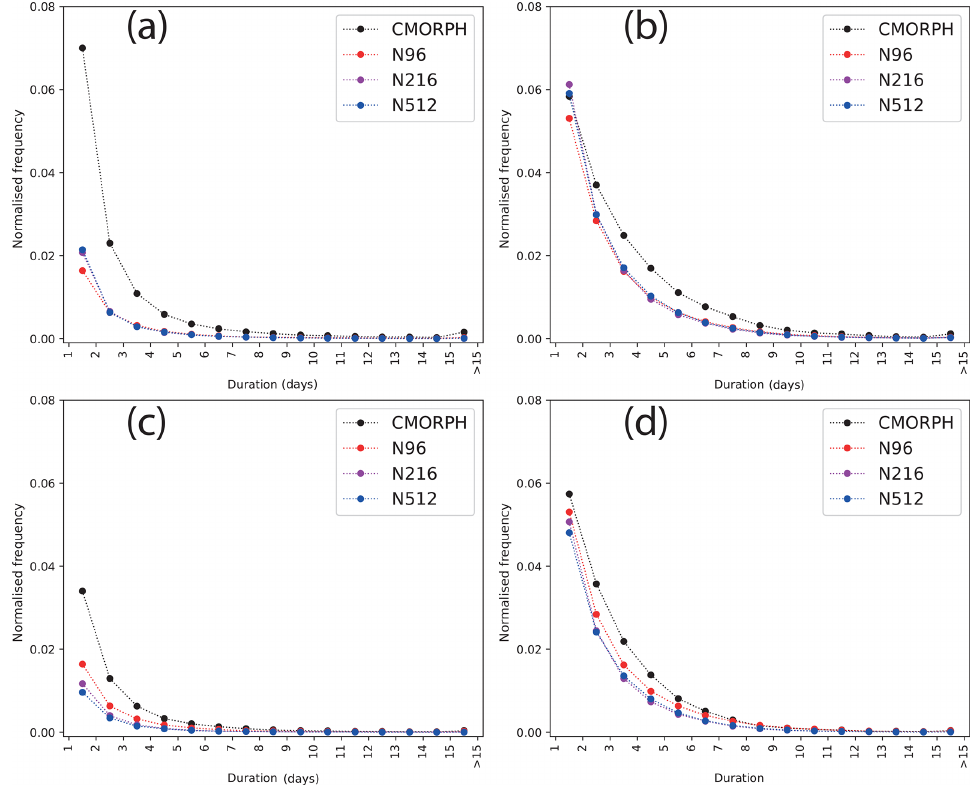
Figure 11. Histograms of dry days (with precipitation less than 0.1mmd − 1 ) lasting for each duration bin, aggregated over all grid points and normalised by the number of spatial and temporal points in each dataset: (a) Amazon and (b) SESA at native resolution for all datasets. Panels (c) – (d) are the same as (a) – (b) but for datasets on the common N96